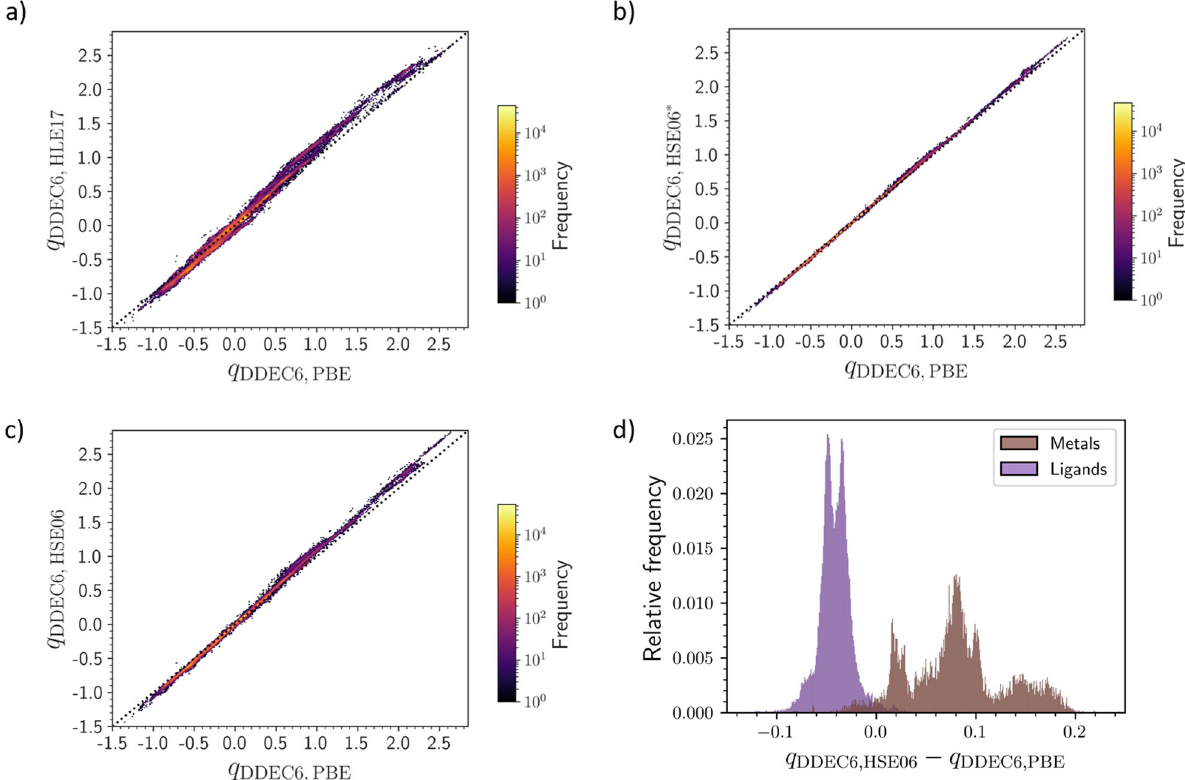
Fig. 4 Correlations between the computed partial atomic charge across multiple levels of theory. Comparison of DDEC6 partial atomic charges, q DDEC6 , for 922,879 atoms based on charge densities at various levels of theory: ( a ) HLE17 vs. PBE; b HSE06 * vs. PBE; c HSE06 vs. PBE. Given the large dataset size, the data is shown as a 2D histogram with the logarithmic color bar re fl ecting the frequency of points in each bin. The y = x line is shown for reference. d A histogram of the change in DDEC6 charges between the PBE and HSE06 levels of theory for the metal sites and ligand atoms within the fi rst coordination